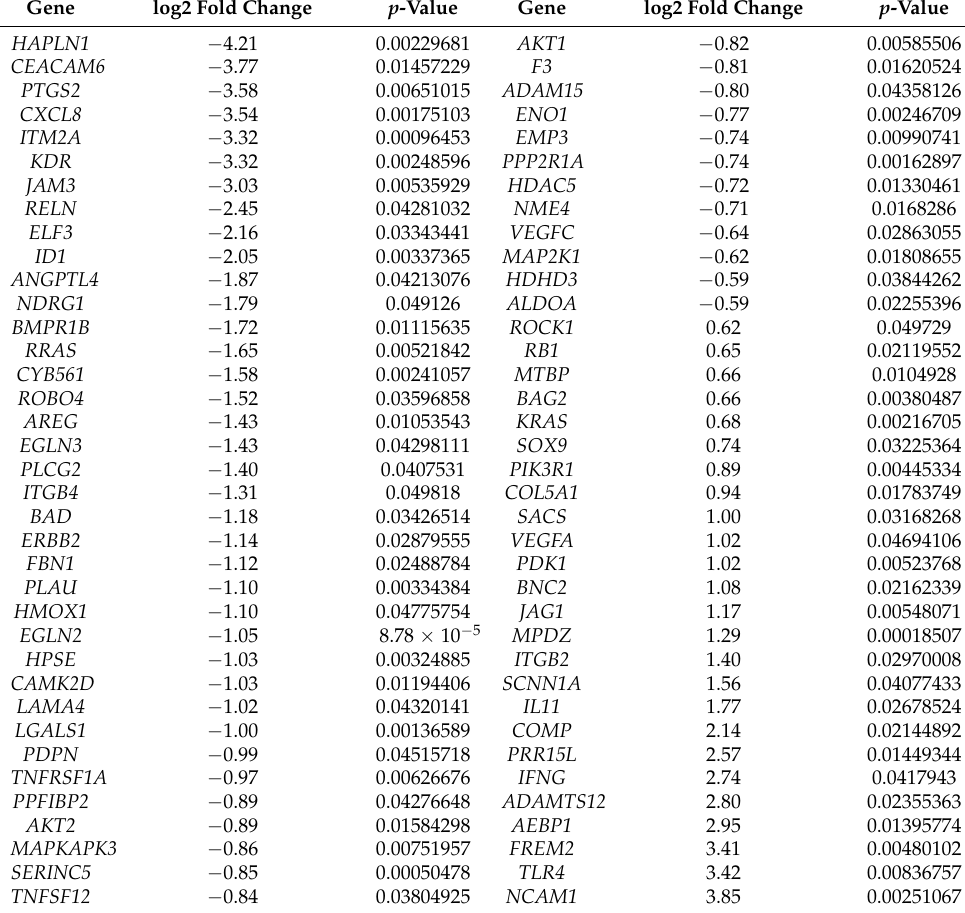
Table 7. Differentially expressed genes in ∆ T + EV PIC versus WT + EV PIC.